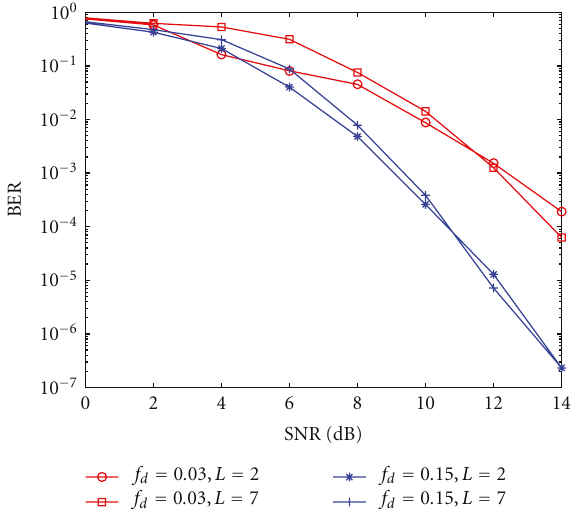
Figure 9: BER comparison of SC